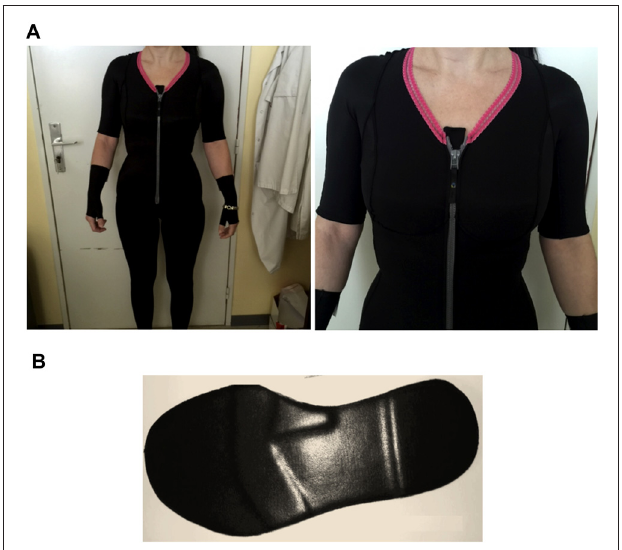
FIGURE 1 | (A) Compression garments (CG) and (B) proprioceptive insoles (PI) worn by an Ehlers-Danlos syndrome hypermobility type (hEDS) patient during the